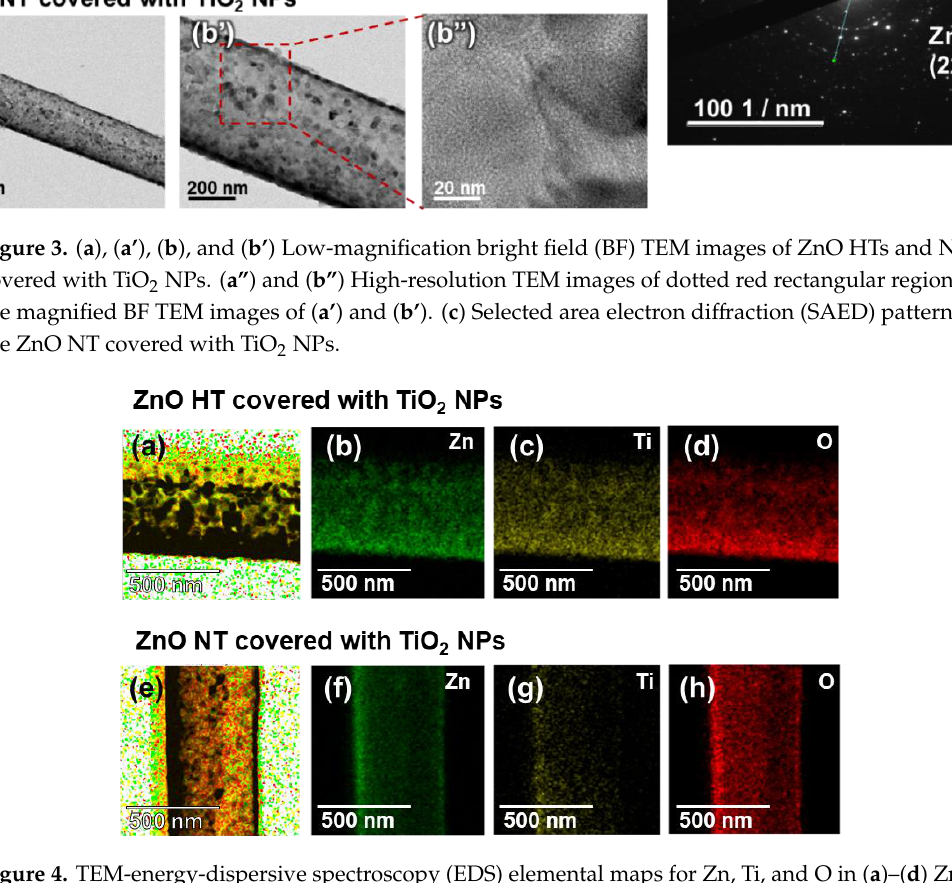
Figure 4. TEM-energy-dispersive spectroscopy (EDS) elemental maps for Zn, Ti, and O in ( a )–( d ) ZnO HT and ( e )–( h ) NT covered with TiO 2 NPs. Table 1. Weight and atomic values of a ZnO HT and a ZnO NT covered with TiO 2 NPs. ZnO HT covered with TiO 2 NPs Element